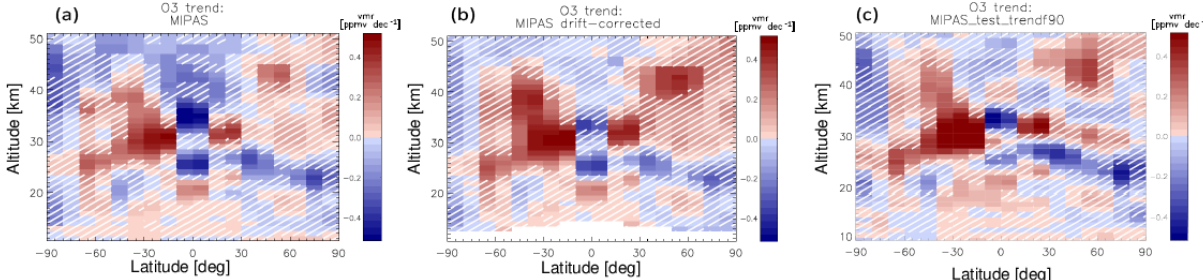
Figure 12. MIPAS 10-year trends calculated based on V5R data without drift correction (a) , drift-corrected V5R data (b) , and V7R data without drift correction (c) . Hatched areas mean that the significance is less than 2 σ